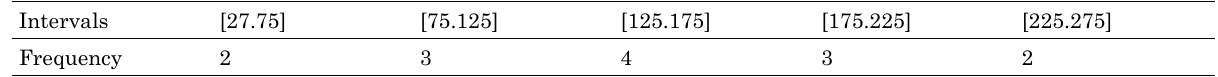
table 8. results of the grouping of the premises indicators Intervals